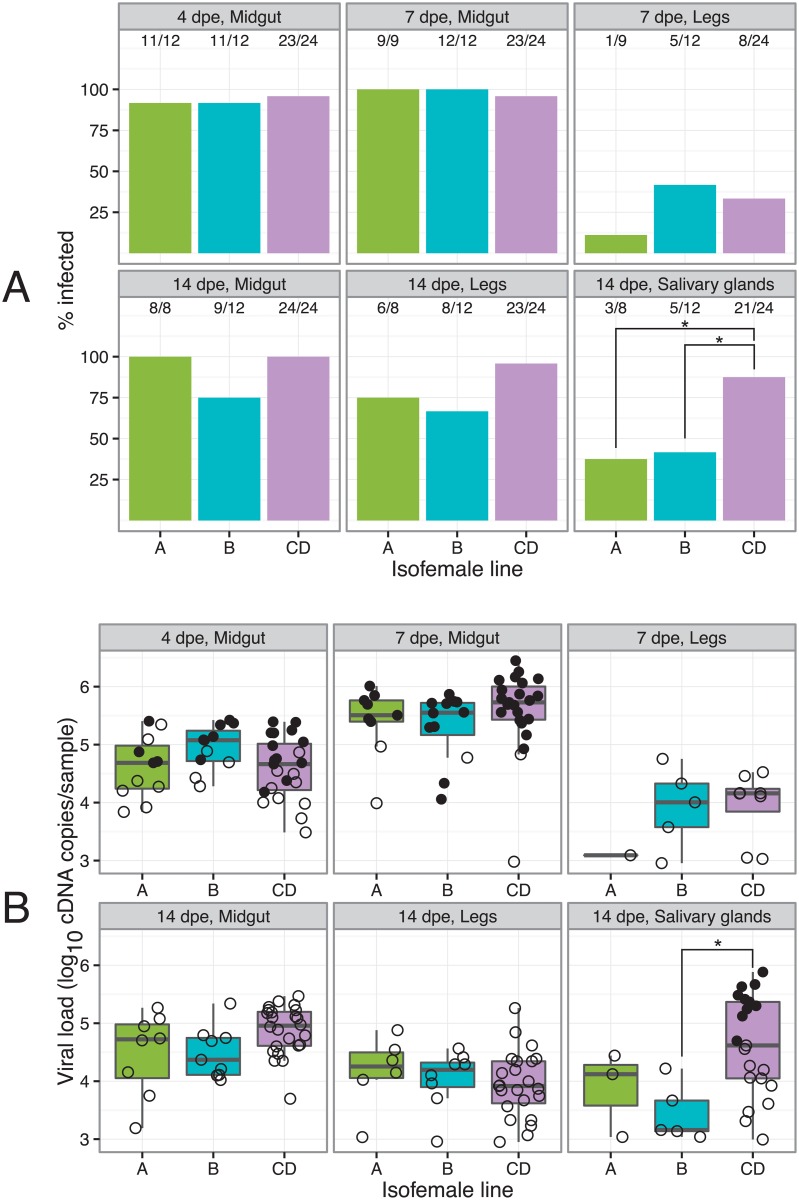
Time course of DENV prevalence and viral load.(A) Bar graphs show the percentage of DENV-infected samples stratified by time point, tissue and isofemale line. Relative numbers of positive samples are indicated above the bars. (B) Box plots show the number of DENV genome copies per infected sample stratified by time point, tissue and isofemale line. Solid dots represent individual samples selected for deep sequencing and open dots represent samples that were not sequenced. dpe = days post exposure. * p<0.05.